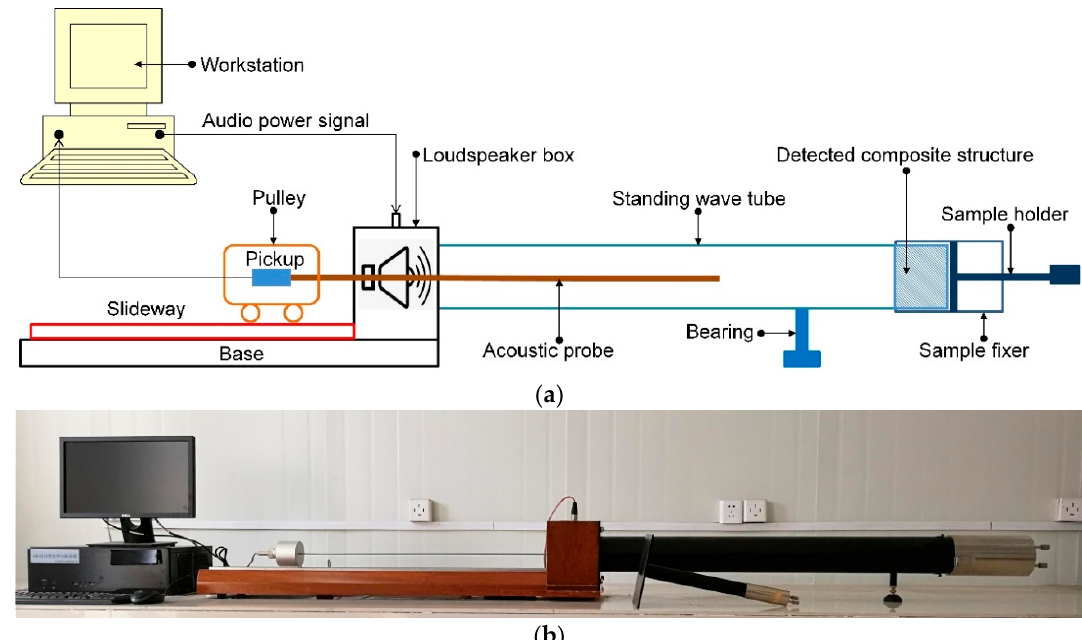
Figure 7. Schematic diagram of AWA6128A detector for measuring the sound absorption coefficient. ( a ) Structure diagram; ( b ) physical picture.